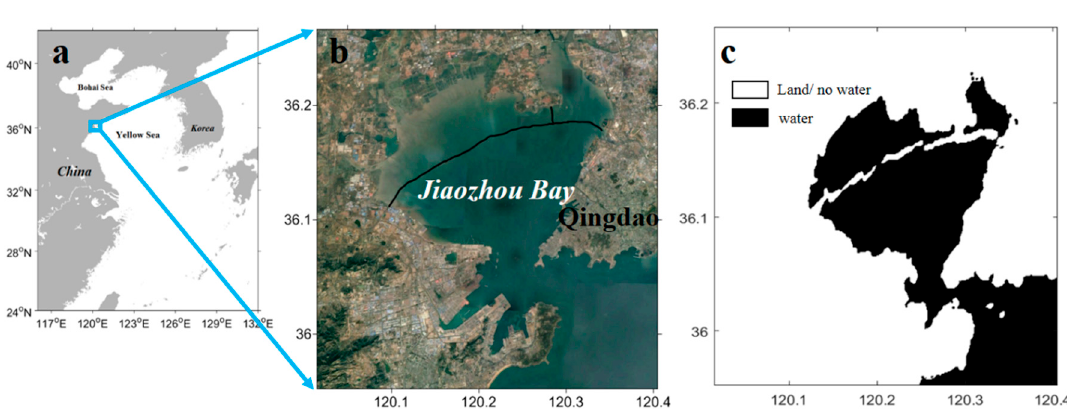
Figure 1. ( a ) Location of Jiaozhou Bay (JZB) on the Yellow Sea coast. ( b ) Satellite image of JZB from Google Earth (provided by DigitalGlobal); the black line shows the JZB Bridge. ( c ) The normalised difference water index distribution for JZB (derived from the Geostationary Ocean Colour Imager). JZB is a typical eutrophic ecosystem characterized by high nitrogen and phosphorus